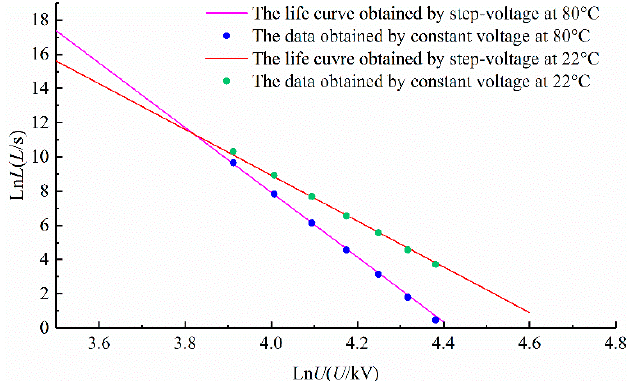
Figure 8. The illustration of model performance.